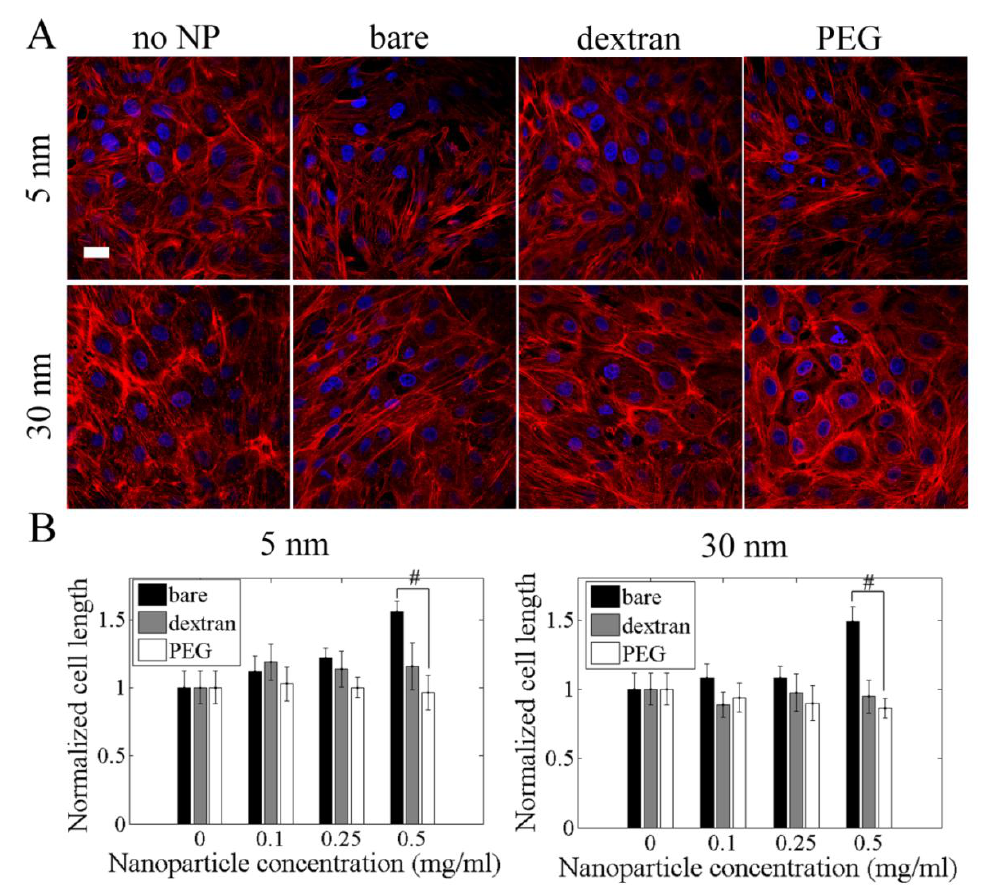
Figure 5. Dextran and PEG coated nanoparticles reduced cell elongation and stress fiber formation. ( A ) Selected confocal images of cells labeled for actin. PAEC were incubated with 0.5 mg/mL bare and coated 5 and 30 nm nanoparticles for 24 h. Samples were then fixed with paraformaldehyde, permeabilized with Triton X-100, and labeled with rhodamine phalloidin (actin, red) and Hoechst (nuclei, blue). Scale bar = 20 µm; ( B ) Cell length was quantified by Image J. # p <